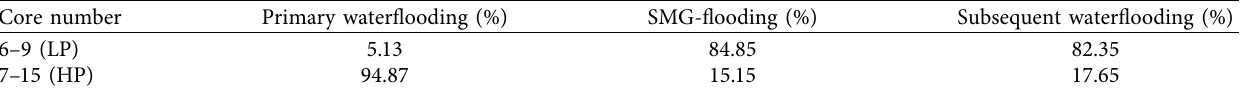
Table 2: Profile control (fraction flow rate, fw ) effect of submillimeter-scale SMG aqueous